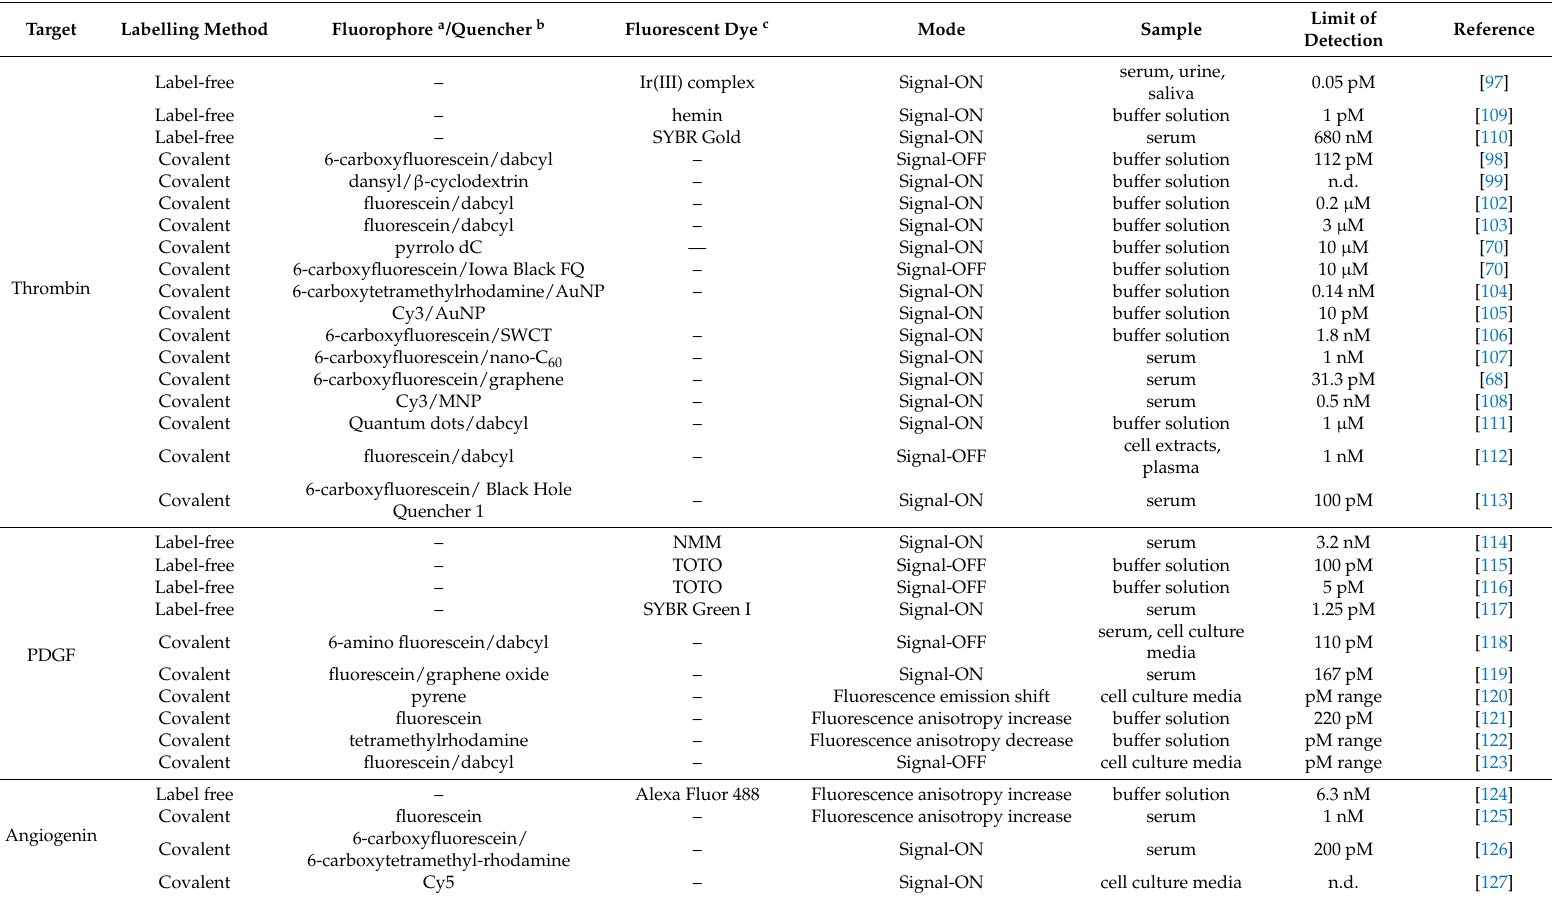
Table 1. Summary of the detection strategies for the here reported cancer-related protein